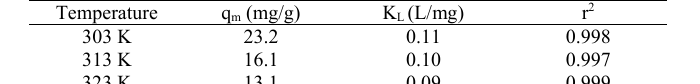
Table 2: Langmuir parameters for the adsorption of methylene blue onto sawdust at 303, 313 and 323 K. Operating conditions: see Fig. 2